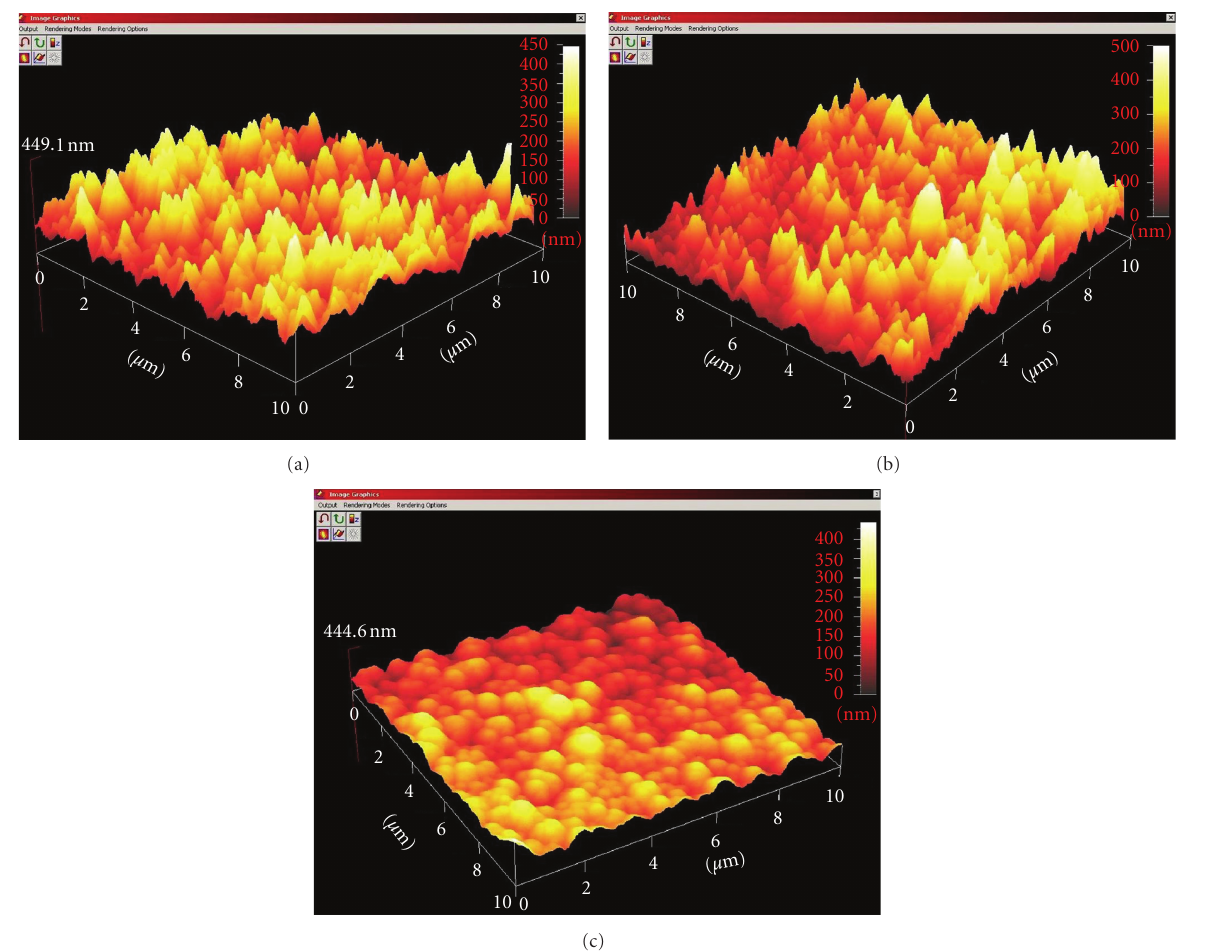
Figure 3: AFM micrographs of ZnO thin films: (a) on the linear moved substrate at the horizontal axis, (b) on the fixed substrate, and (c) on the rotated substrate in the horizontal